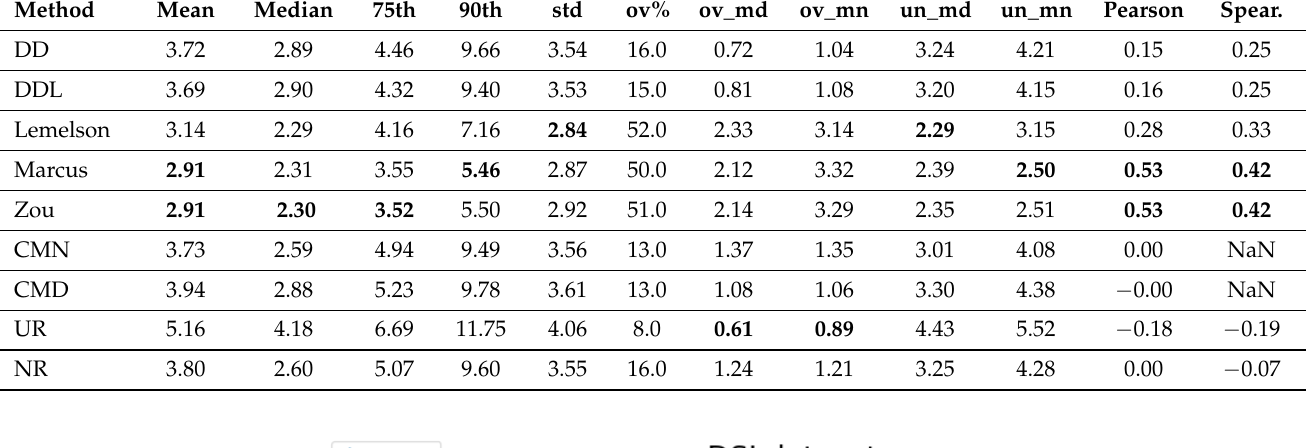
Table 6. The performance of all studied methods and baselines, based on various evaluation metrics, on the validation set of the DSI dataset. The first 5 columns report statistics ( mean, median, 75th percentile, 90th percentile, and standard deviation ) of the absolute DAE error. The next column “ ov% ” describes the percentage of DAE overestimation (the percentage of estimates where the actual location is “ inside the DAE circle ”). The mean and median DAE error of the overestimated estimates is reported under “ ov_ mn ” and “ ov_ md ”, respectively. The same statistics for the underestimation case are provided under “ un_ mn ” and “ un_ md ”, respectively. Lastly, Pearson’s correlation coefficient and Spearman’s (rank) correlation coefficient between the DAE values and the actual positioning errors are reported in the last two columns. The best performance for each metric is highlighted in bold.